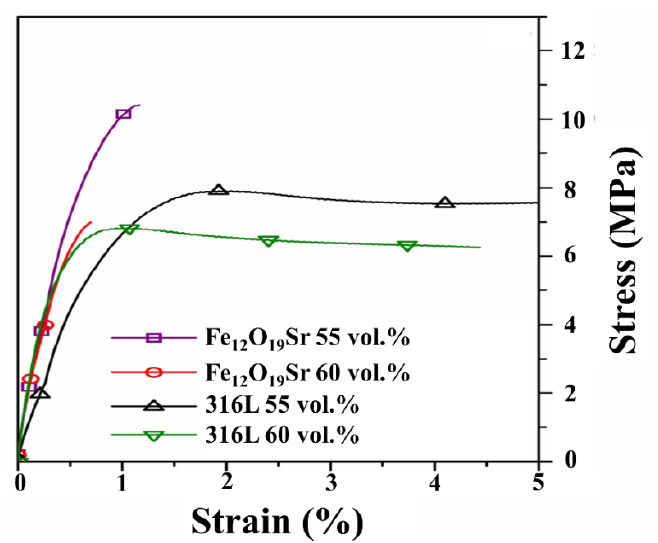
Figure 8. Tensile curves of and Fe 12 O 19 Sr and 316L filament with different solid loading, showing the reduction in strain with 5% increment of solid loading (adapted from [4]).